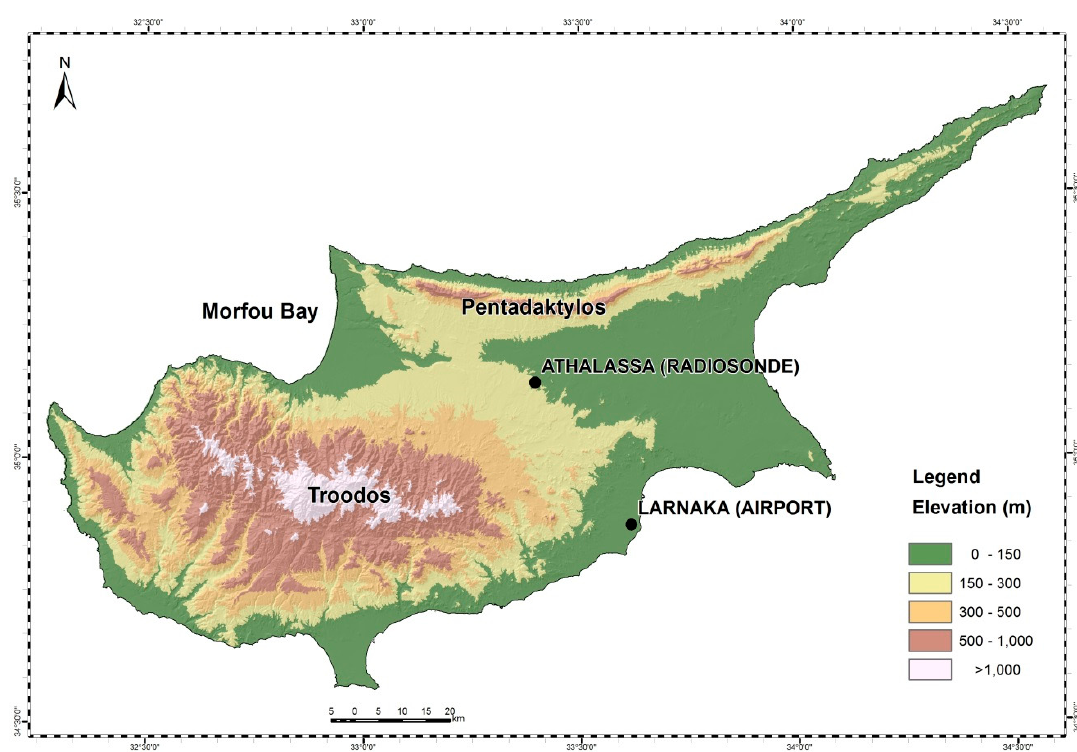
Figure 1. Map of Cyprus showing the location of Athalassa radiometric station. CG1 pyrgeometers obtained from Kipp and Zonen were used to measure the longwave radiation. All the sensors are factory calibrated, in accordance with the World Radiometric Reference (WRR) [33]. About 9% of the upward longwave irradiance data values are missing, while the percentage of the downward longwave irradiance which is missing is about 25%. The missing data are caused either from problematic functioning of the CG1 pyrgeometers or from problems related to the data logger system. Long missing data for both longwave irradiances are observed in the year 2017. Details about the quality control procedures for the shortwave solar radiation measurements can be found in [34]. Longwave Radiation Quality Control The process of quality control for the longwave radiation is based on range tests which were suggested by the Baseline Surface Radiation Network (BSRN) group. BSRN has proposed globally physical possible, extremely rare, and climatological configurable limits as well as global cross-comparisons for the surface longwave radiation measure- ments [32] (Table 2). The “physically possible” tests detect extremely large errors in the radiation data. The radiation data falling in the intervals defined by the range between 40 and 700 W/m 2 for downward longwave irradiance and between 40 and 900 W/m 2 for the upward longwave irradiance are considered “physically possible”. The data set passed the sug- gested physical limits. The “extremely rare” limits are narrower than those of the “physically possible” lim- its, since they usually occur over very short time periods under very extreme conditions. Therefore, “good quality” is assumed to be inside the “extremely rare” limits. Figure 2